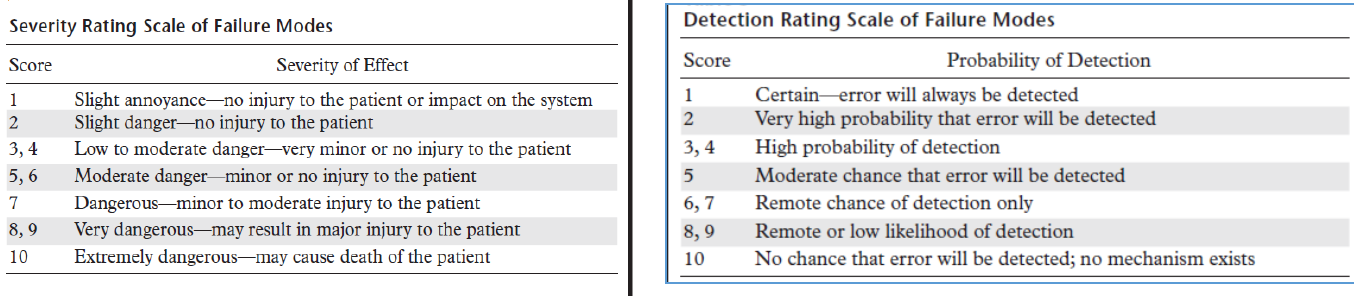
Figure 2 . Detec�on ra�ng scale of failure